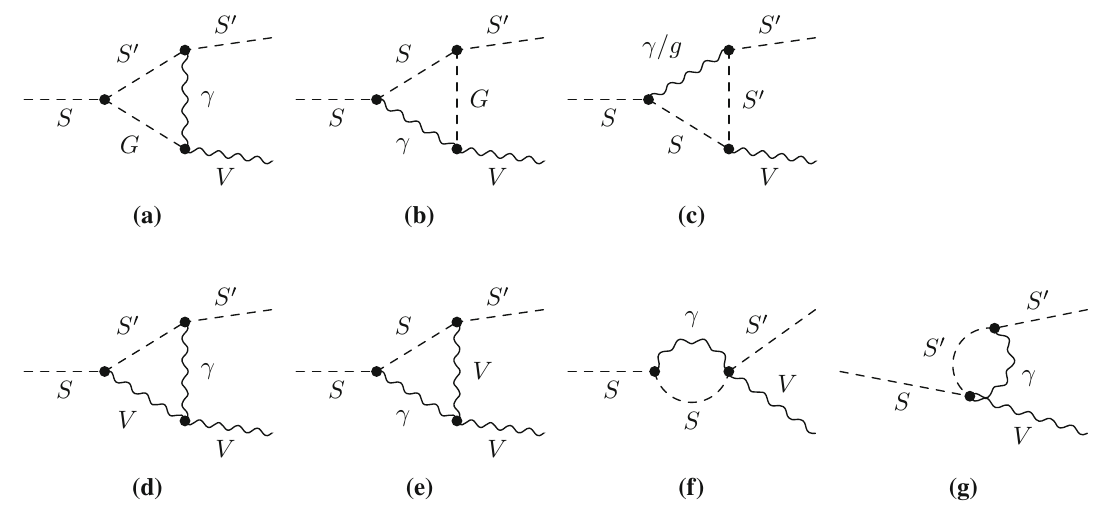
Fig. 21 Diagrams in the decay F → F (cid:5) V that are potentially infrared- divergent. Clearly a and d must combine in a gauge-invariant way, so thatwhenweputthemassesoftheexternalstatestotheirloop-corrected